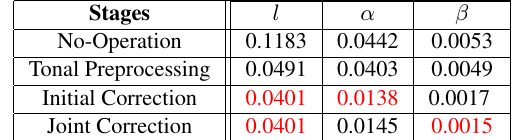
Table 2. Average tonal differences in l , (cid:11) and (cid:12) channels after different processing stages for real multi-temporal images shown in Figure 8(a).